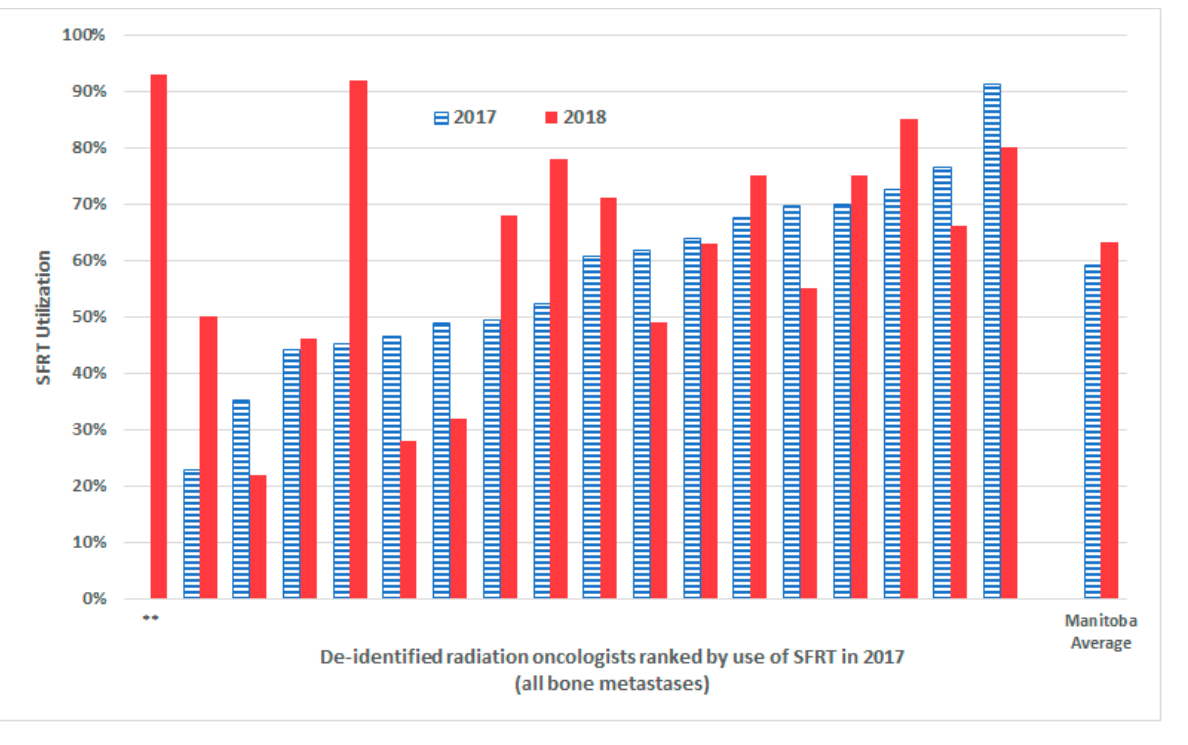
Figure 1. Proportion of SFRT utilized in by de-identified individual radiation oncologists for all bone metastases in 2017 and 2018 in Manitoba (**: Radiation oncologist joined the team in 2018 and has no 2017 comparison point). Table 2. Year-over-year change in proportion of bone metastases treated with SFRT by individual radiation oncologists for all bone metastases. Only clinicians who participated in the KT campaign (17/18) are included.